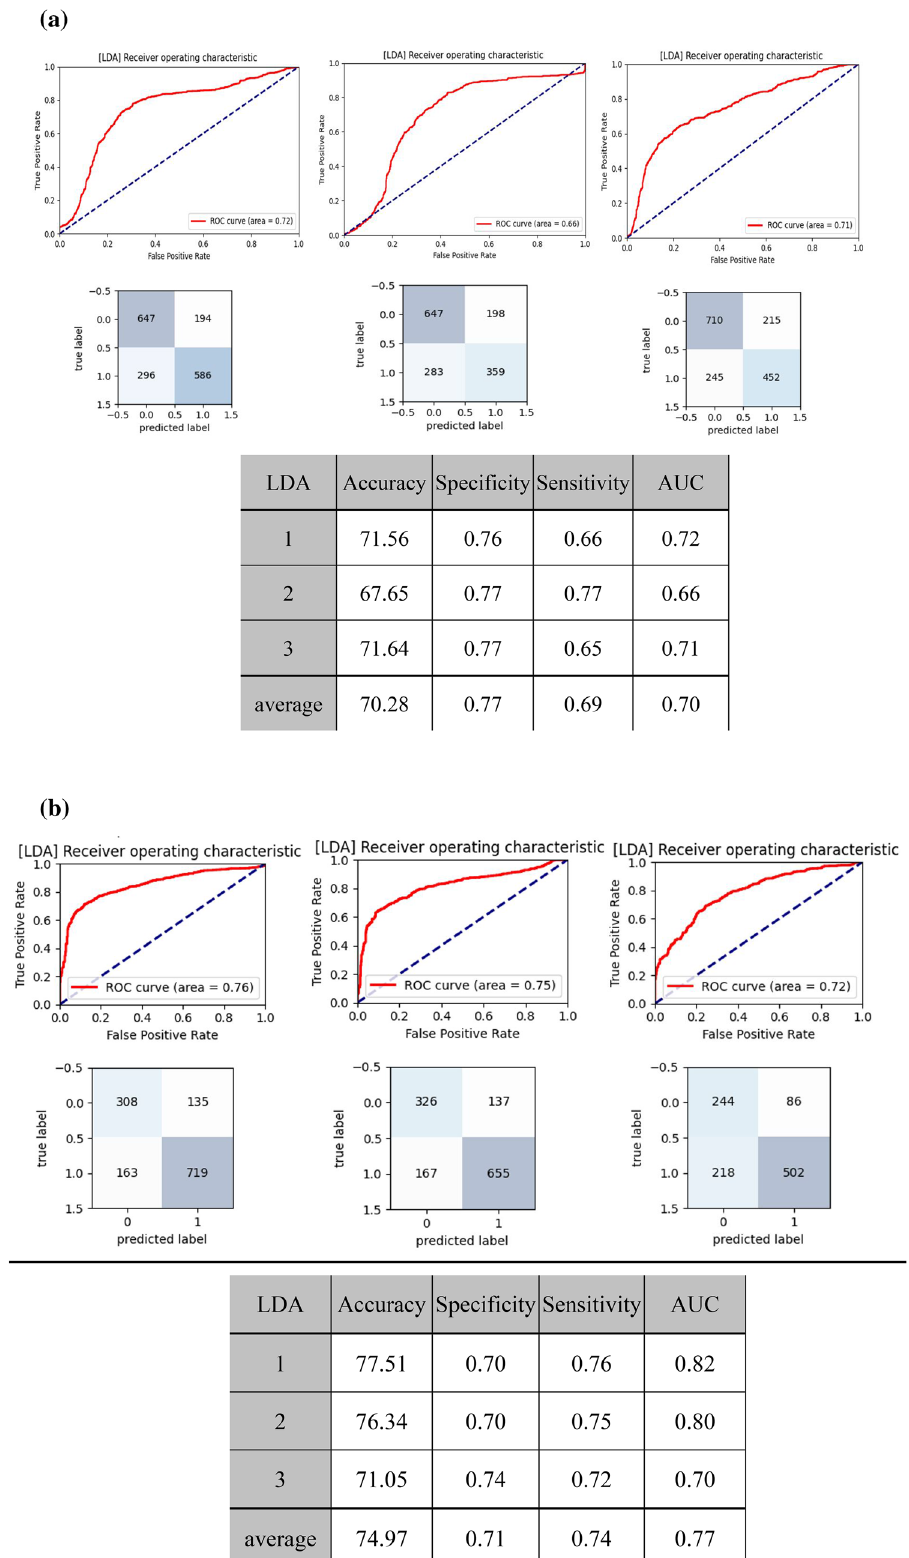
Figure 7. Results of ML analysis (LDA) of BPW indices. ( a ) discriminating between robust and possible sarcopenia. ( b ) discriminating between robust + no-MetS and possible